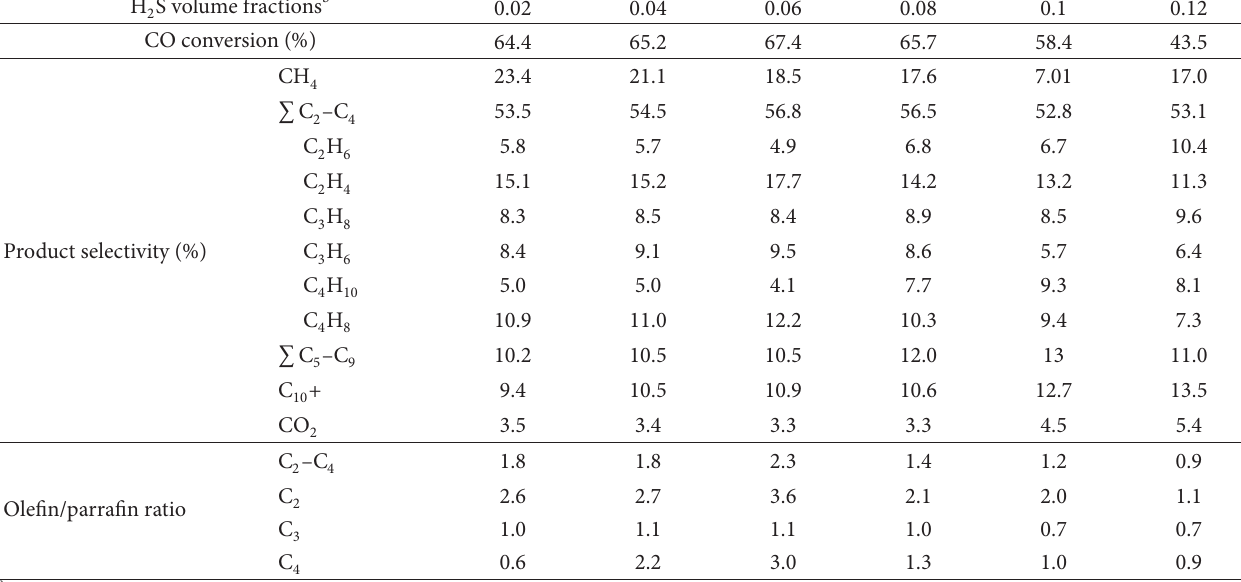
T 2: Effect of different H S volume fractions on the catalytic performance of catalyst a 2